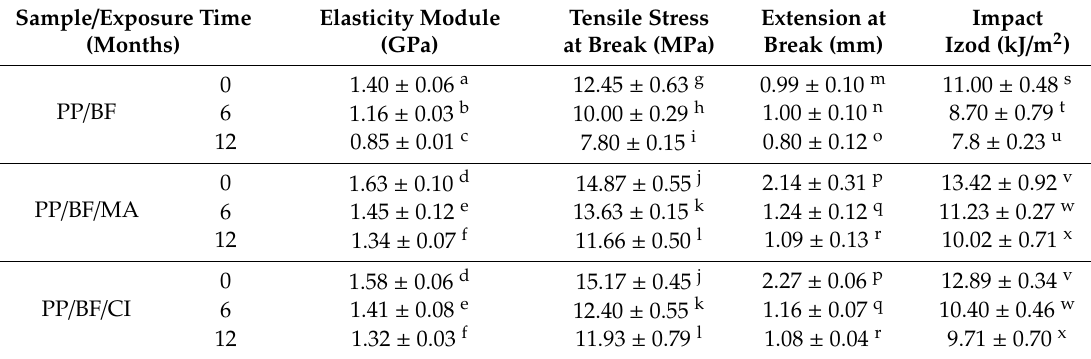
Table 3. Summary of the mechanical properties of the composites before and after natural aging. Sample / Exposure Time